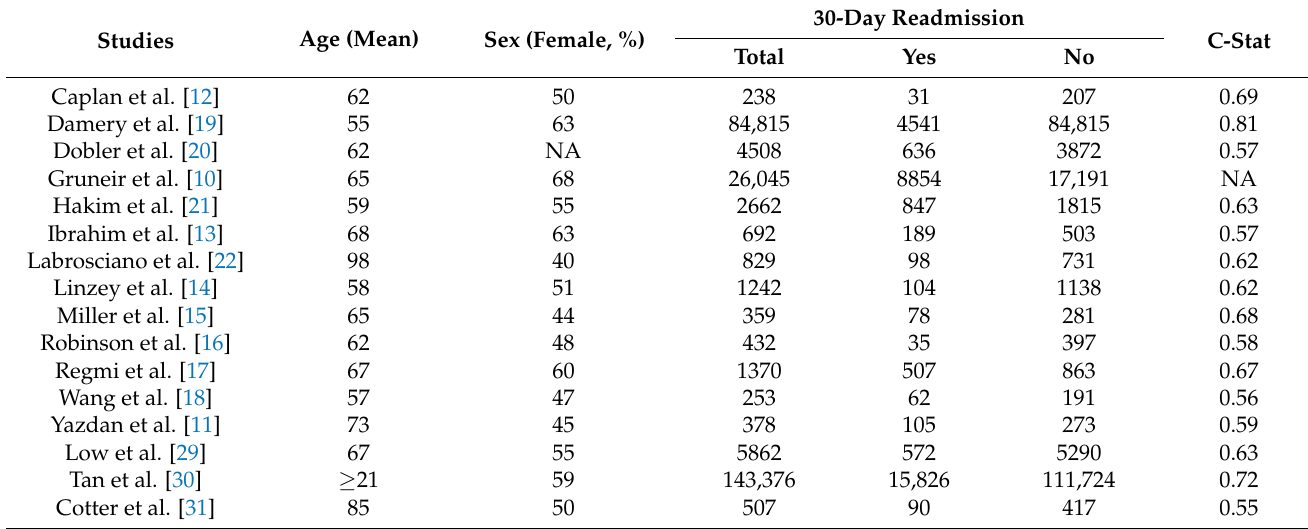
Table 2. Baseline Characteristics of LACE Index to Predict Risk of 30-day Readmissions of selected studies.